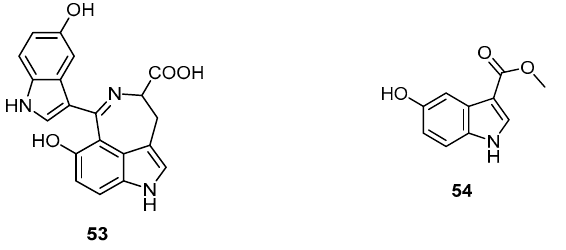
Figure 13. Chemical structures of hyrtiazepine ( 53 ) and compound 54 .